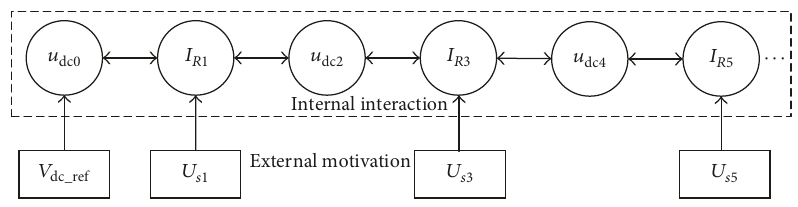
Figure 3: Harmonic interaction law of single-phase